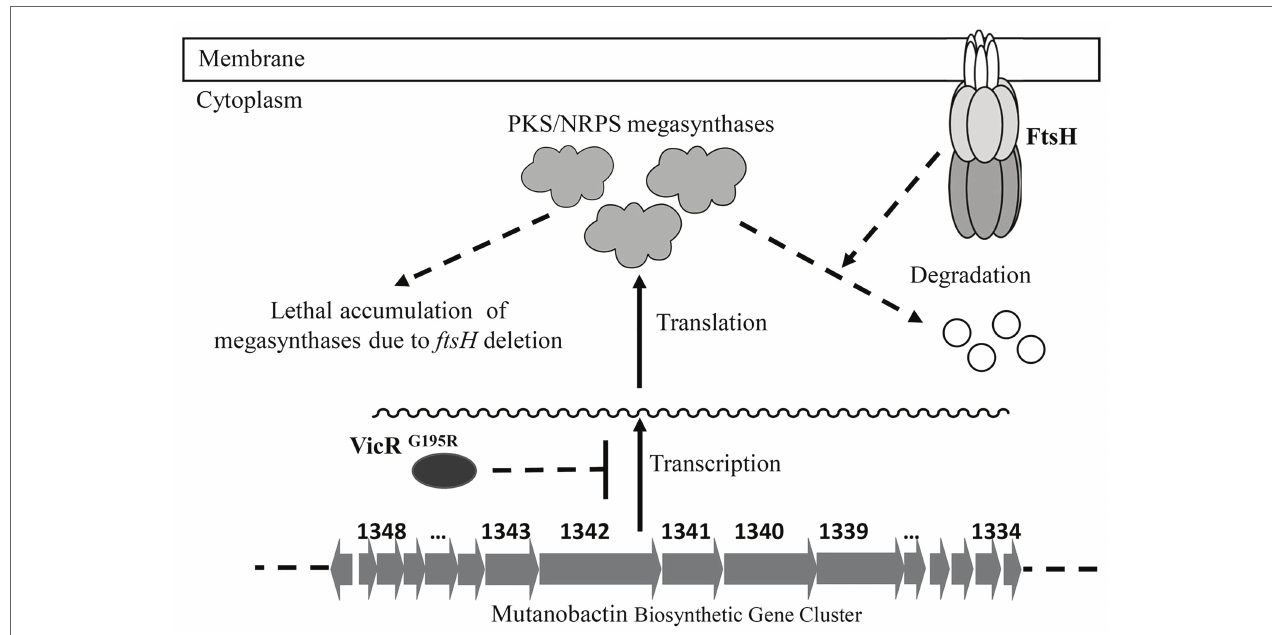
FIGURE 6 | Model of FtsH essentiality in S. mutans . The mutanobactin biosynthetic gene cluster contains the largest operon in the genome of S. mutans . The protein products of this locus are PKS/NRPS megasynthases, which are also among the largest S. mutans proteins. It is hypothesized that FtsH is required for the turnover of these megasynthases, and the accumulation of these proteins in ftsH deletion strain is lethal to the bacterial cell. The VicR G195R mutation results in reduced transcription of the entire mutanobactin biosynthetic gene cluster, leading to reduced ftsH mutant toxicity and a suppression of the FtsH mutant lethal